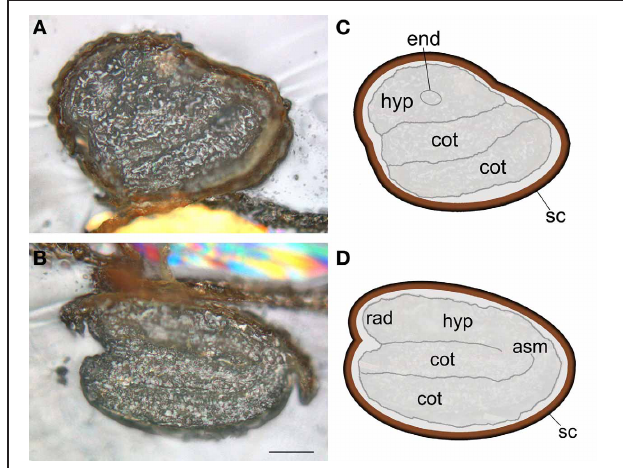
FIGURE 1 | Arabidopsis thaliana dry seed structure. Light microscopy images of transversal (A) and longitudinal (B) sections with respective schematic representations (C,D) . Thirty micrometer sections were obtained at − 30 ◦ C using a cryomicrotome. Scale bar: 100 µ m; asm, apical shoot meristem; cot, cotyledon; end, endodermis; hyp, hypocotyl; rad, radicle; sc, seed